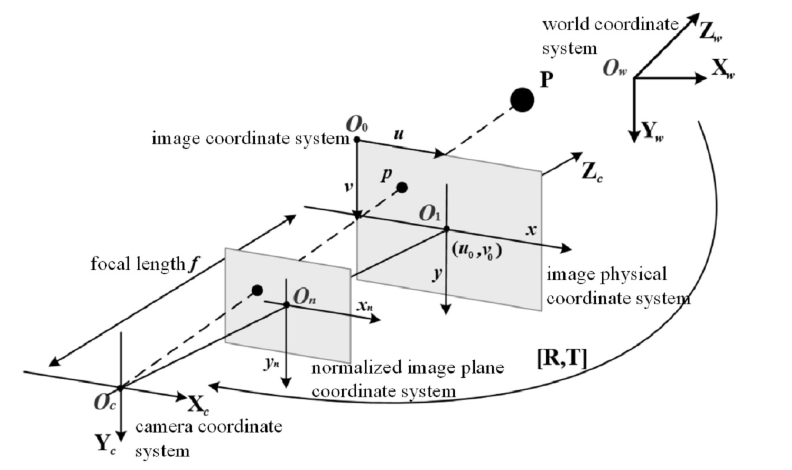
Figure 2. Coordinate system diagram of camera imaging